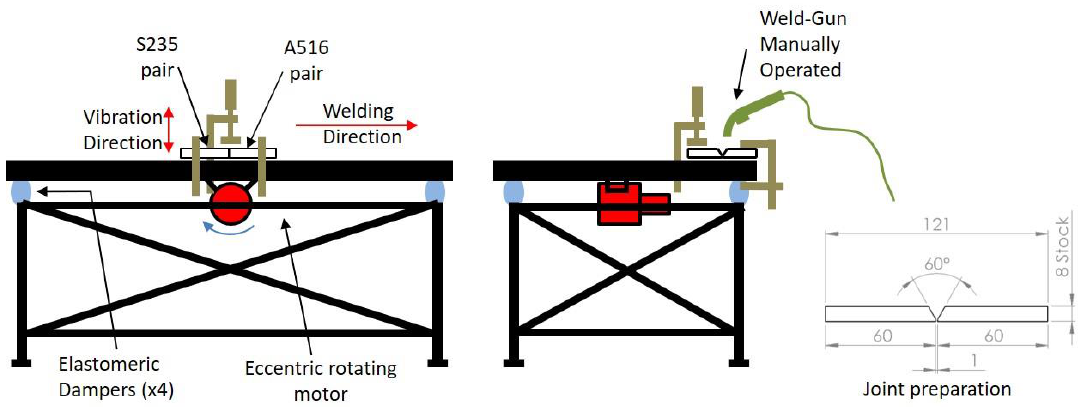
Figure 2. Schematic weld table setup. For each frequency, both pairs of samples (S235 and A516 steels) were welded at the same pass. On the right: The geometry of joint preparation.